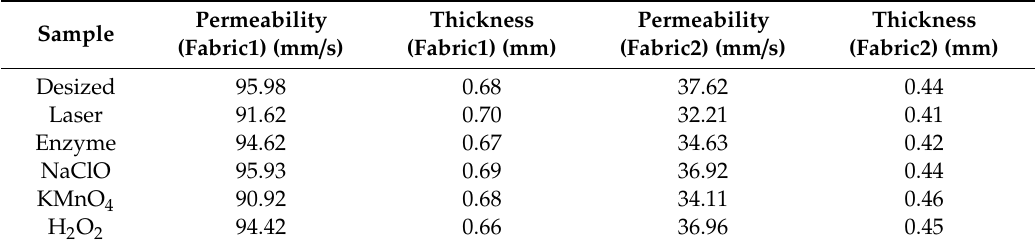
Table 6. Permeability and thickness of denim fabrics with di ff erent bleaching